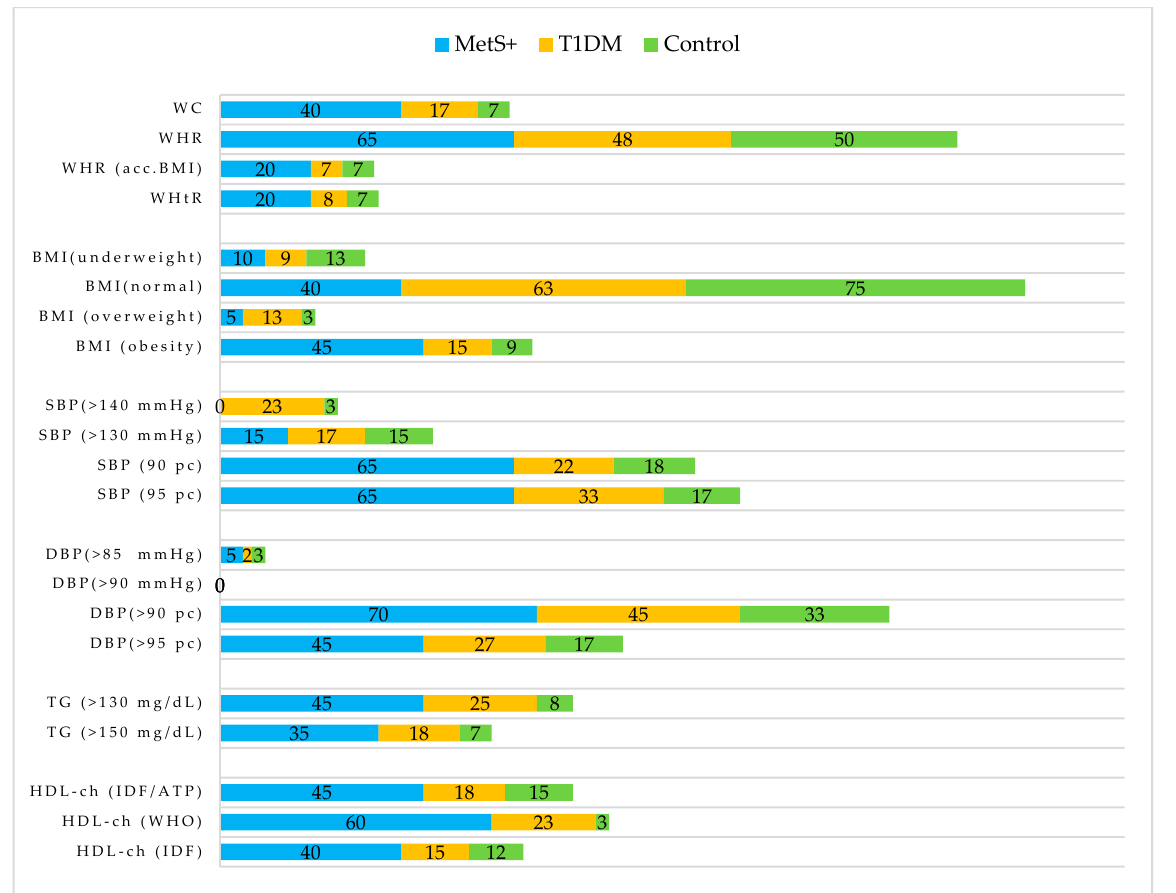
Figure 3. Percentage of participants meeting the metabolic syndrome components. Values are expressed as percentage of respondents (%). WHR (acc.BMI) includes the percentage of persons who are overweight or obese and, additionally, have a WHR above normal. BMI classifications for underweight, overweight, and obesity in the pediatric population correspond to the 10th, 85th, and 97th percentiles, respectively. Abbreviations: National Cholesterol Education Program Adult Treatment Panel III (ATP), body mass index (BMI), diastolic blood pressure (DBP), high-density lipoprotein cholesterol (HDL-ch), International Diabetes Federation (IDF), metabolic syndrome (MetS), systolic blood pressure (SBP), type 1 diabetes mellitus (T1DM), triglycerides (TG), waist circumference (WC), World Health Organization (WHO), waist–hip ratio (WHR), waist-to-height ratio (WHtR).